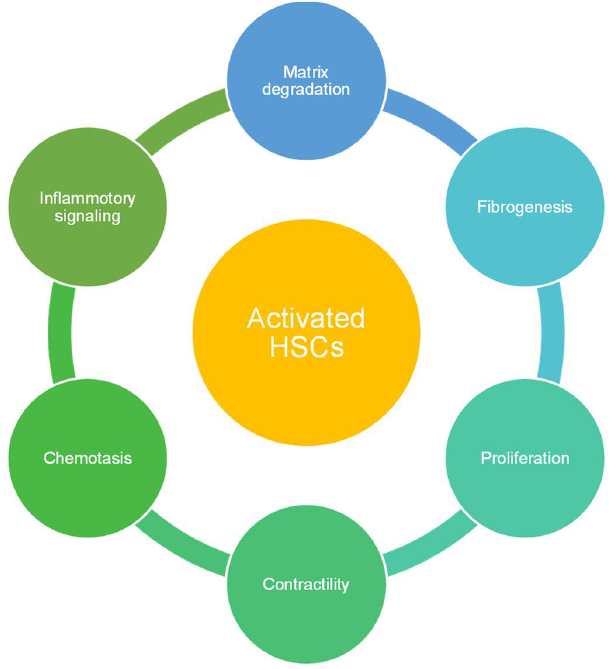
Figure 2. Functions of activated HSCs in diseased livers [19].